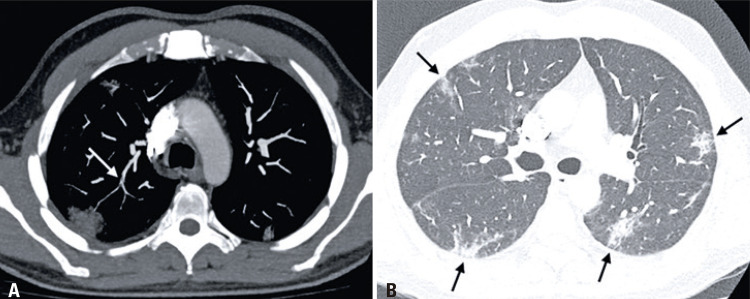
Angiotomografia computadorzada de tórax (paciente de 49 anos). (A) Corte axial em janela de mediastino evidenciando falhas de enchimento de ramos arteriais segmentares e subsegmentares no lobo superior direito (seta branca), achados compatíveis com tromboembolismo pulmonar. (B) Corte axial em janela para avaliação do parênquima pulmonar com múltiplas opacidades em vidro fosco, associadas a espessamento de septos interlobulares, com distribuição bilateral e periférica (setas pretas), achados consistentes com pneumonia por coronavírus